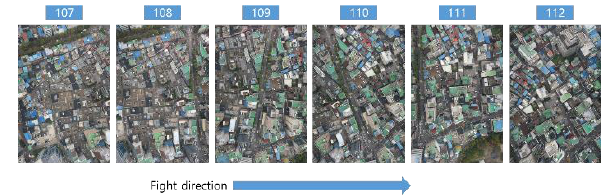
Figure 7. UAV images acquired in the flight direction